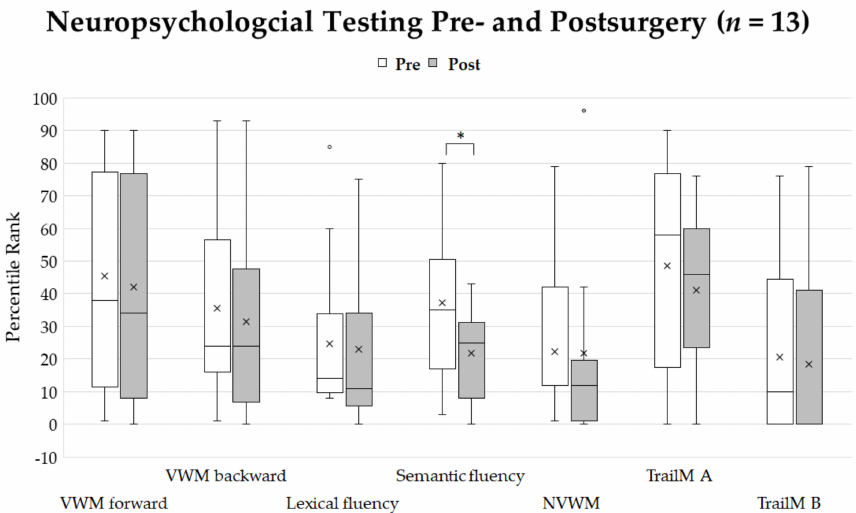
Figure 4. Percentile ranks of neuropsychological testing before and after surgery. Crosses show the mean values. Asterisk shows significant differences of percentile ranks ( p < 0.05). The only significant difference was seen for semantic verbal fluency. Abbreviations: VWM-visual working memory, NVWM-non-visual working memory, TrailM A-Trail-Making Test A, TrailM B-Trail-Making Test